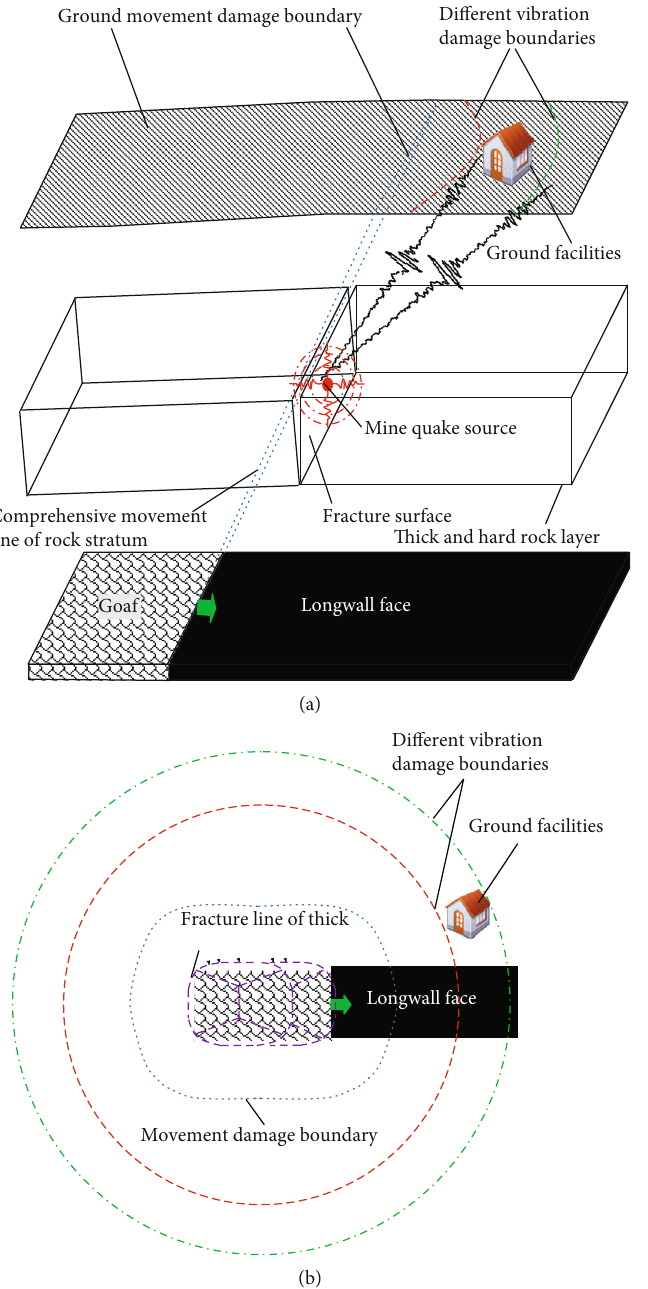
Figure 2: Schematic diagram of potential damage boundaries of stope ground in the thick and hard rock layer. (a) Space diagram; (b) Plan